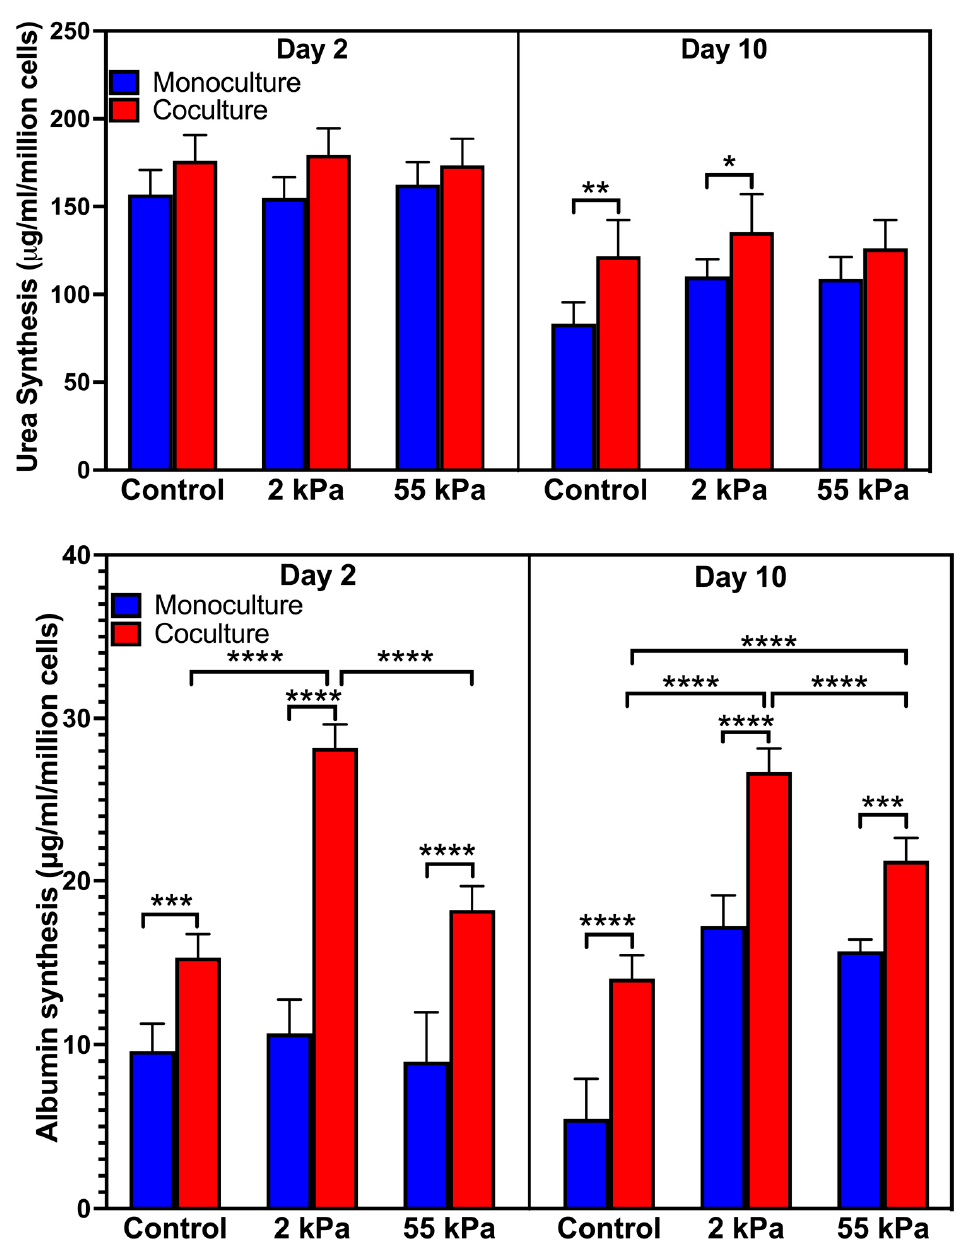
Figure 3. Hepatic urea and albumin expression as a function of gel stiffness in the monoculture and coculture. ( A ) Quantification of urea synthesis by primary hepatocytes on soft (2 kPa), stiff (55 kPa), and TCPS substrates; ( B ) quantification of albumin synthesis primary hepatocytes cultured on soft (2 kPa), stiff (55 kPa), and TCPS substrates. Error bars indicate standard deviation of the mean for n = 5 samples. * p < 0.05, ** p < 0.01, *** p < 0.001, **** p < 0.0001.